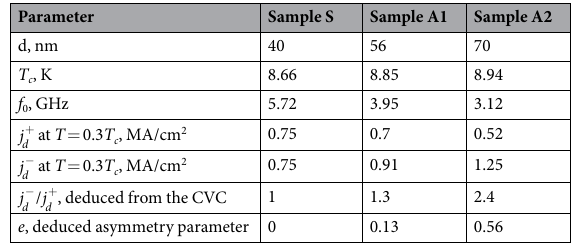
Table 1. Main parameters of the investigated Nb